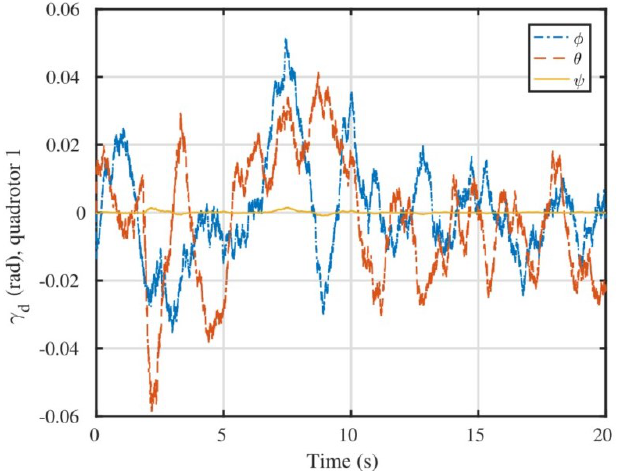
Figure 6. Commanded attitude of sub-UAV 1 expressed in Euler